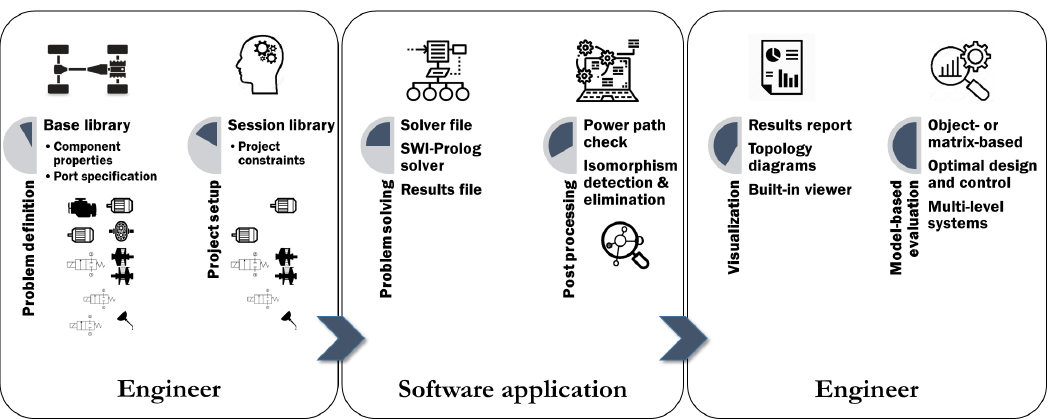
Figure 11. A new computer-aided engineering (CAE) tool for fully automated dynamic system topology synthesis applied to all-electric and hybrid-electric powertrain systems from the system to component level. A graphical user interface was developed for the ‘engineer’ based on the software attributes shown on the left-hand and right-hand sides, whereas the constraint programming (CP) solver and post-processor running on the software application are shown in the middle. The sequential process steps are indicated by the